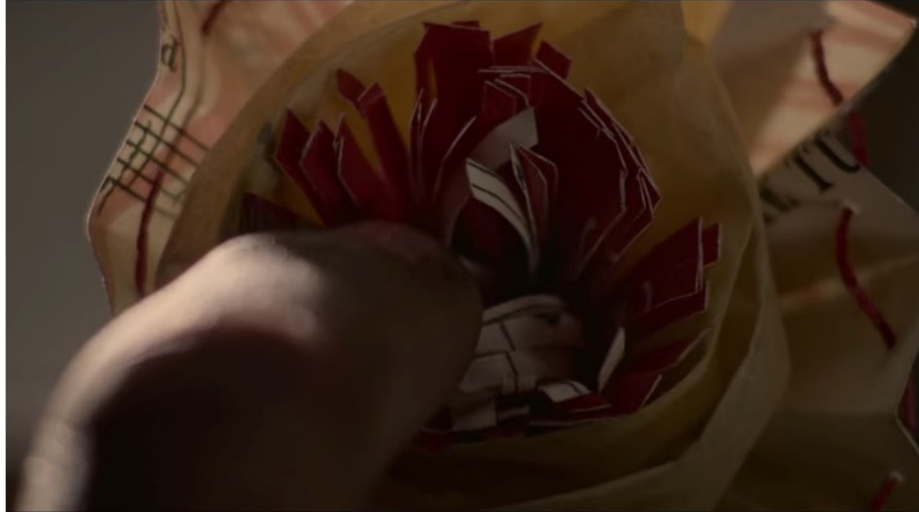
Figure 8. The Power of the Dog . Netflix.